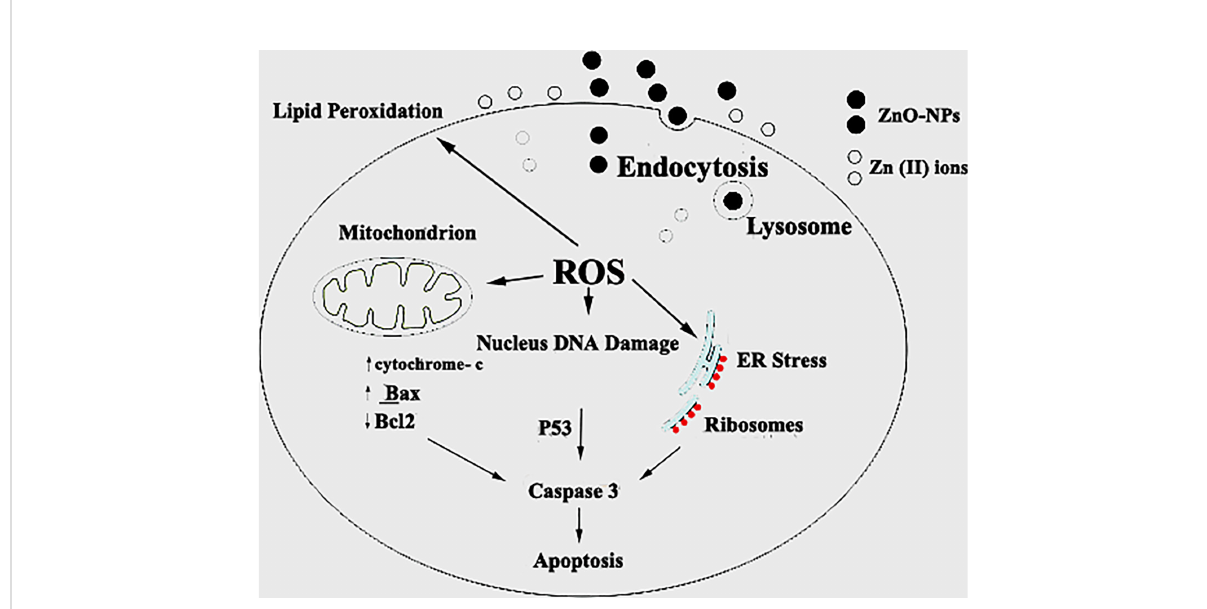
FIGURE 14 Schematic diagram of the probable mechanism of synergy of ZnO-NS. ZnO-NS are involved in reactive oxygen species (ROS) generation and increased cell wall lipid peroxidation (LPO) leading to cytotoxic and genotoxic